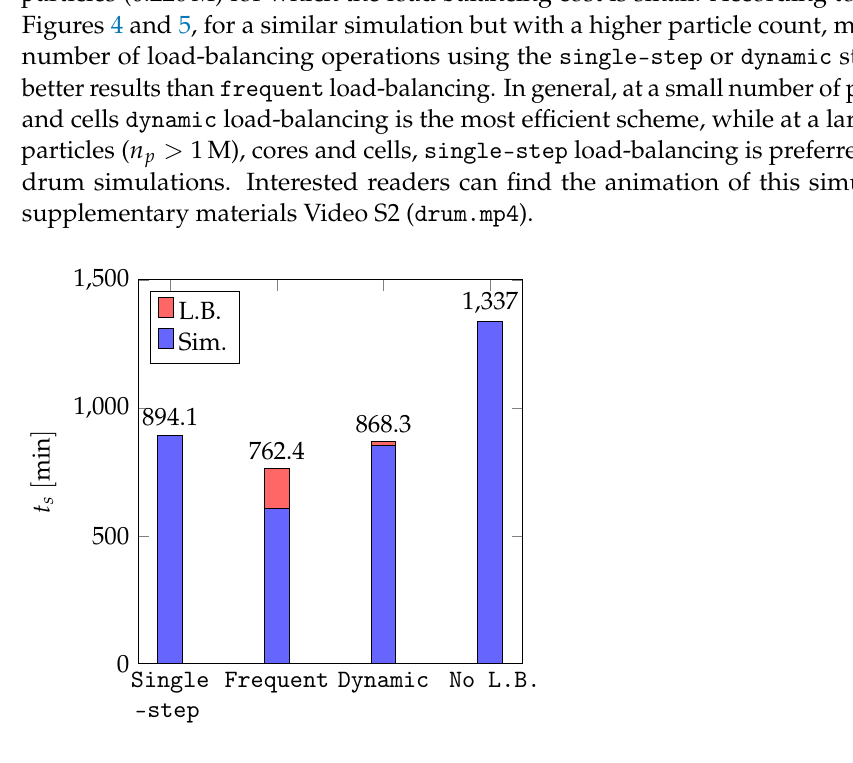
Figure 8. Simulation times of the rotating drum benchmark with different load-balancing schemes. Load-balancing time is illustrated using the red